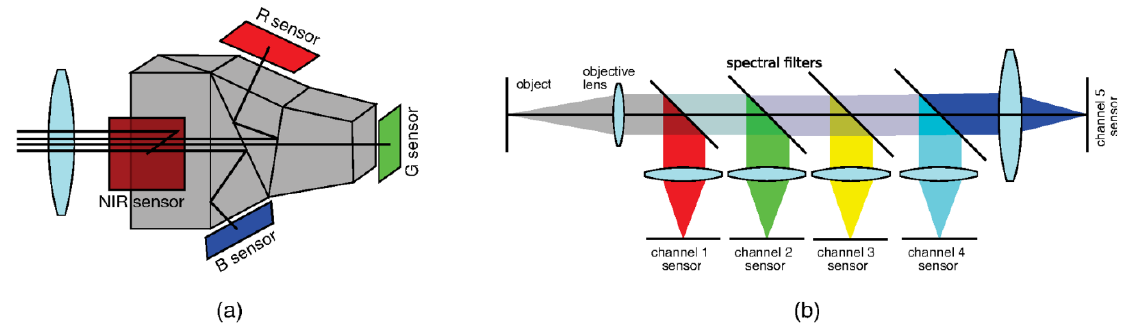
Figure 6. Different multispectral system layouts can be employed based on beam splitting using ( a ) monolithic prism blocks or ( b ) a sequence of spectral filters. Reproduced from [43] under license CC BY 3.0.